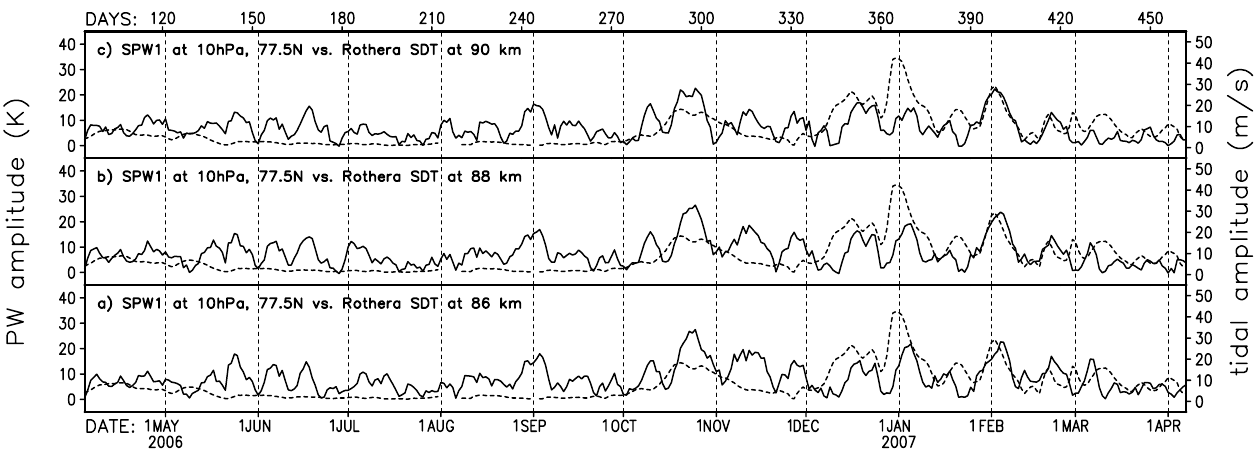
Fig. 12. Time sequences of the stationary planetary wave 1 amplitudes at 10hPa, 75–80 ◦ N (dashed line; scale on left axis, shown in all panels) versus the Rothera (68 ◦ S, 68 ◦ W) meridional semidiurnal tide amplitudes (solid line; scale on right axis) at 86 (a) , 88 (b) and 90km (c) for